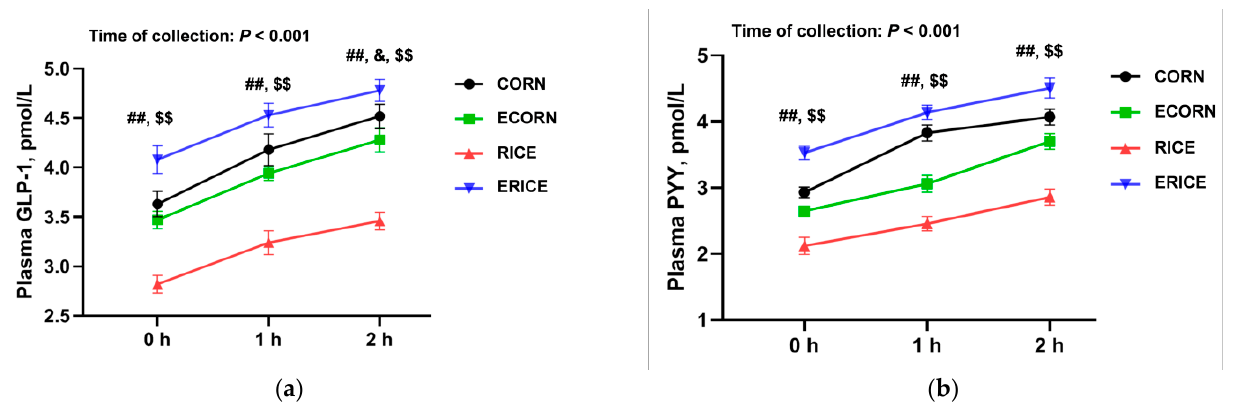
Figure 1. Effect of cereal types and extrusion processing on the plasma concentration of GLP-1 ( a ) and PYY ( b ) of weaned piglets. Values are means ± SEM, n = 8. $$, p extrusion process < 0.01; ##, p interaction < 0.01. &, p cereal types < 0.05. Table 5. Effects of cereal types and extrusion processing on levels of glucose, insulin, and ghrelin of weaned piglets.